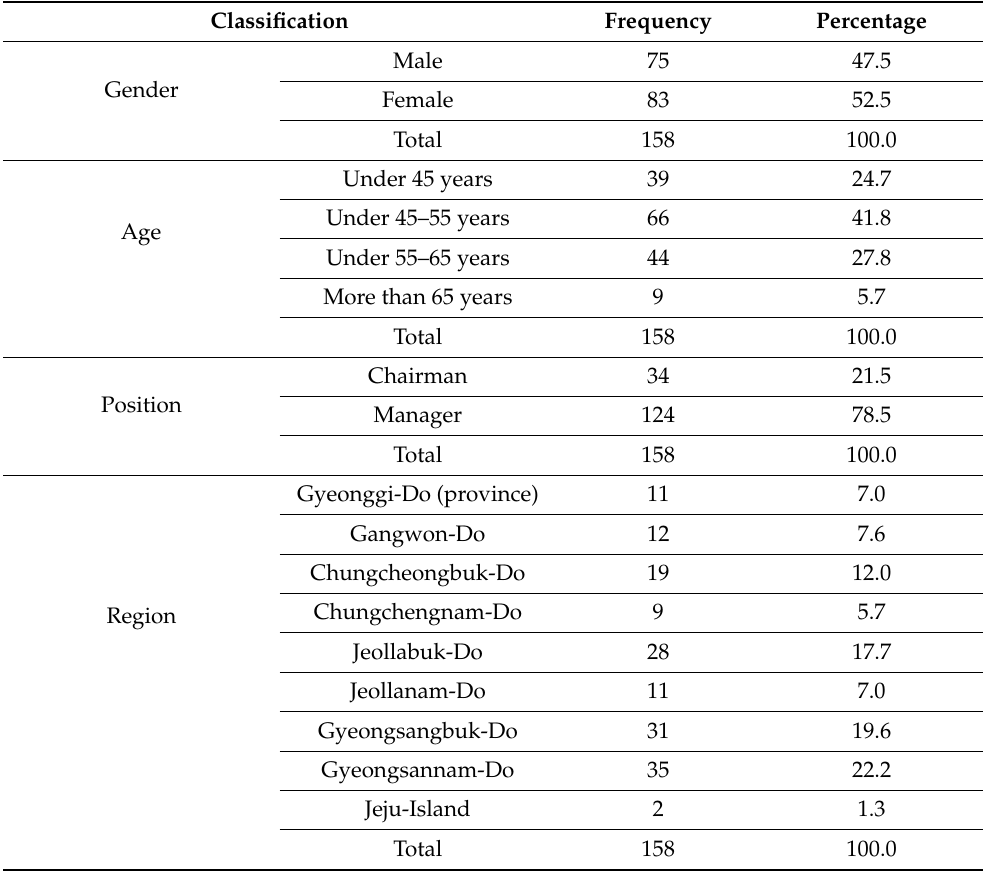
Table 2. The general demographics of respondents to the construct and reliability validity